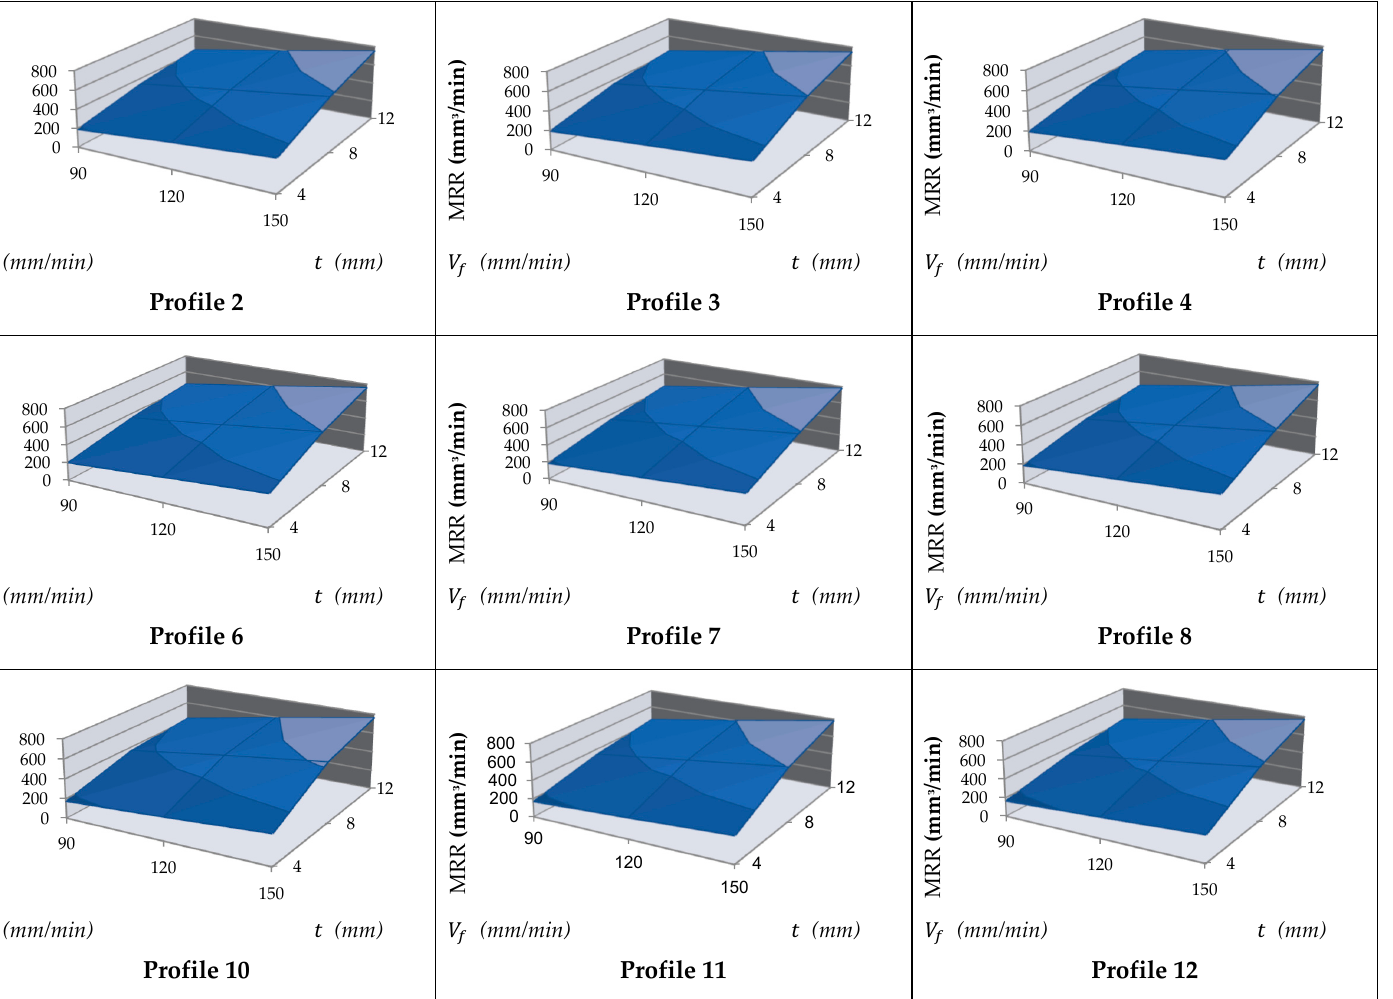
Figure 7. Impacts of material thickness and traverse speed towards material removal rate in AWJ profile cutting of AISI304L.